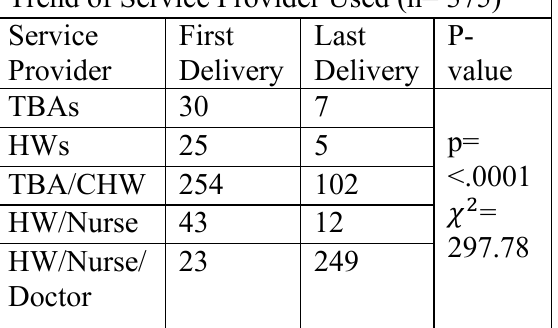
Table 2 indicates practice of using service